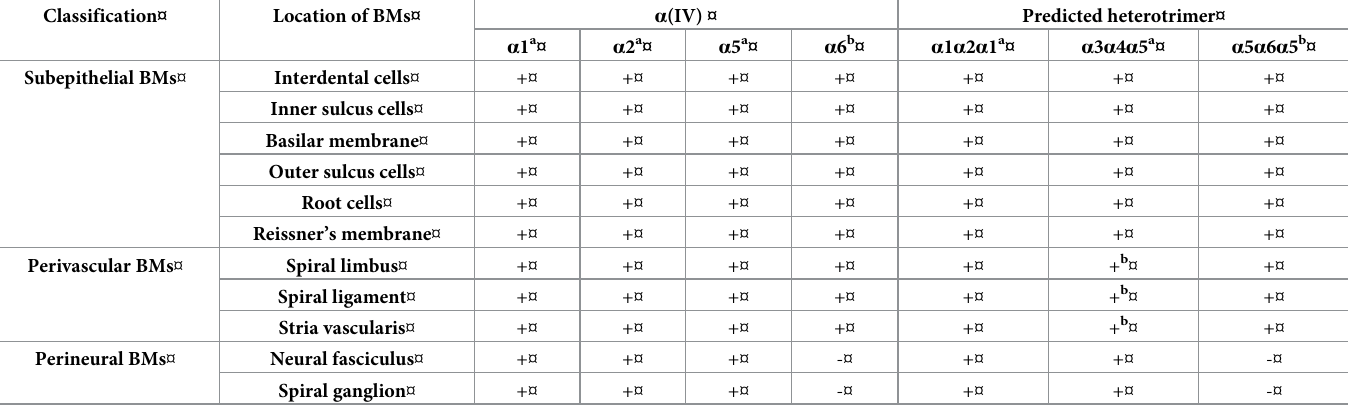
Table 1. Qualitative assessment using immunohistochemistry: Distribution of collagen α 1(IV), α 2(IV), α 5(IV), and α 6(IV) chains and the predicted molecular composition of the collagen IV network in mouse cochlea. Classification¤